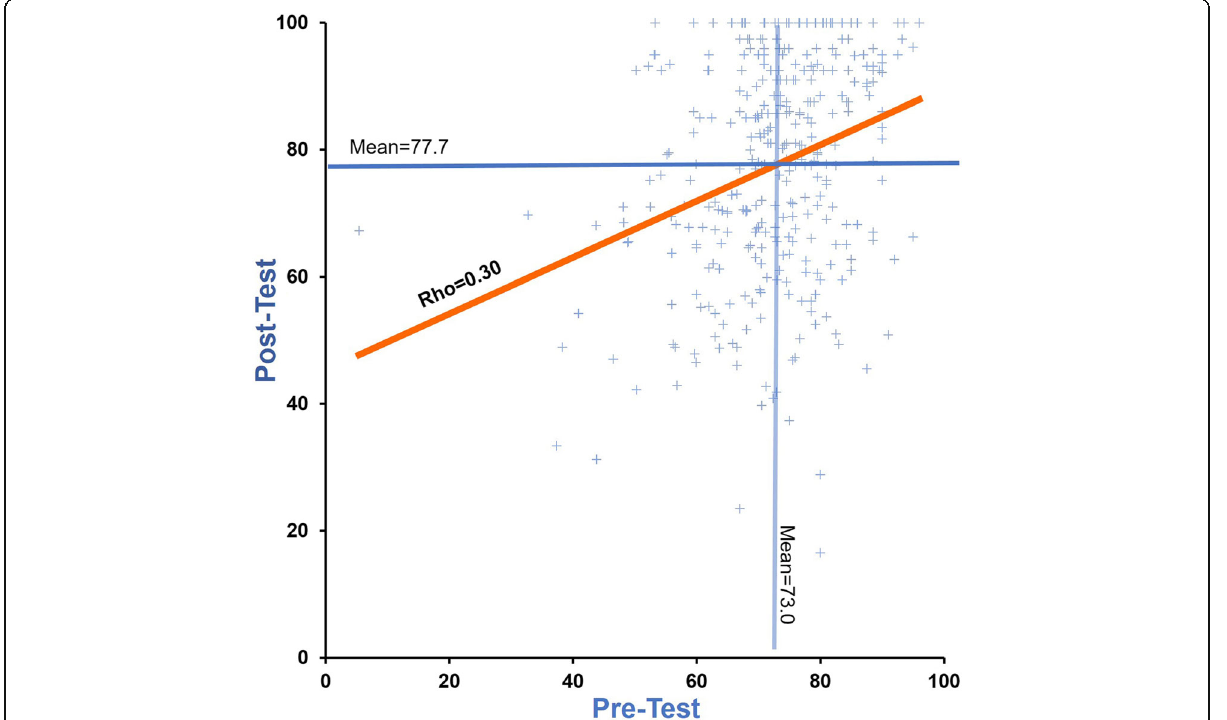
Fig. 2 Evaluating performances: pretest vs. posttest comparison using Bland-Altman test. The average score was 73.0 for pretest and 77.7 for posttest. The absolute change was therefore an increase of 4.7 ± 17.5 points overall ( P < 0.05). There is a correlation between the average value overall and the improvement between the pretest and posttest (Spearman ’ s rho =